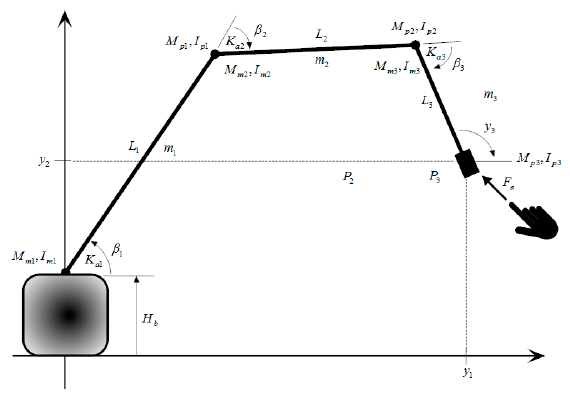
Figure 14. Considered planar robot.